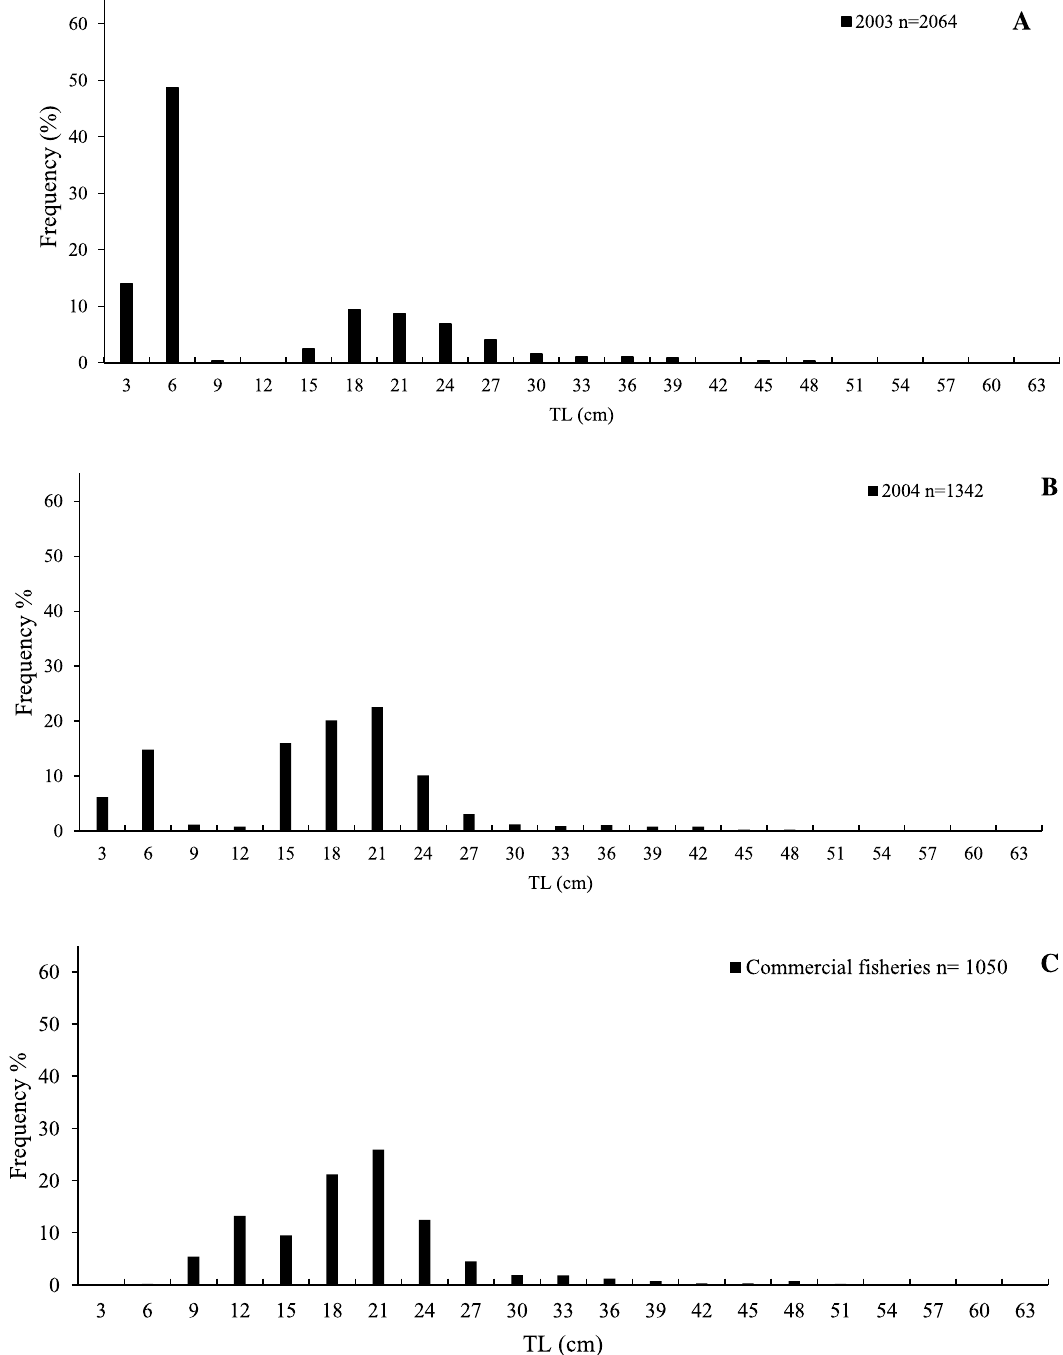
Fig. 5. Length frequency of P. blennoides caught from bottom trawl surveys in 2003 (A) and 2004 (B) and commercial fi sheries in the algerian coast (n: number of